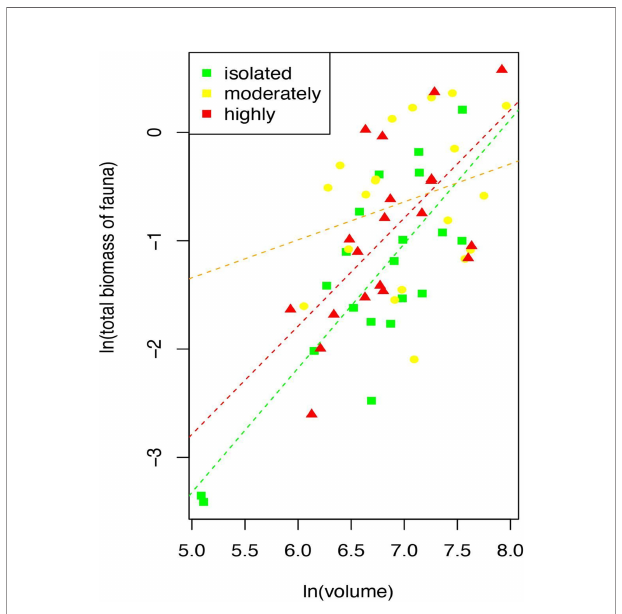
FIGURE 6 | Relationship of the total biomass of fauna and volume of rhodoliths by each level of aggregation of rhodoliths (Isla del Coco, Costa Rica).